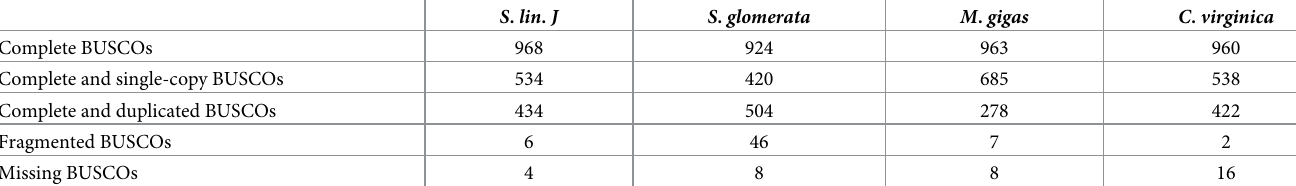
Table 2. BUSCO results for both Saccostrea species compared to Crassostreinae whole-genome data.